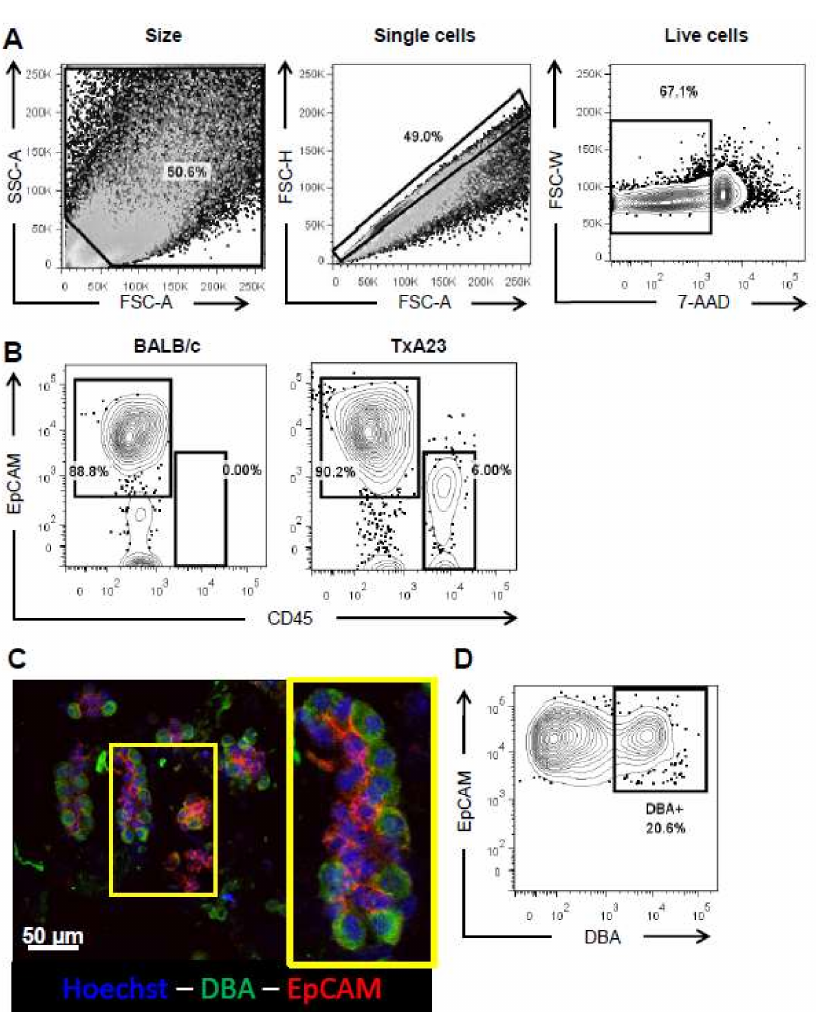
Figure 2. Gating strategy for analyzing gastric epithelial cells by flow cytometry. ( A ) A gate based of forward area and side scatter area is first established, these cells are then put through a forward scatter area and forward scatter height gate to identify single cells, finally, 7-AAD is used to separate live cells from dead/dying cells; ( B ) Representative flow plots of live single cells from healthy BALB/c and TxA23 mice stained with an epithelial cell marker (EpCAM) and an immune cell marker (CD45). Immune cells are undetectable in the gastric mucosa control mice, and present in TxA23 mice that have autoimmune gastritis; ( C ) Representative immunocytochemistry of glands isolated from a 2 month old BALB/c mouse and stained with hoechst (blue), parietal cell marker Dolichous bifluorous agglutinin (DBA, green), and anti-EpCAM (red) with a high magnification inset in yellow showing an individual gland; ( D ) A representative flow cytometry plot of live single cells from a BALB/c mouse stained with anti-EpCAM and DBA demonstrating a subset of EpCAM + DBA + parietal